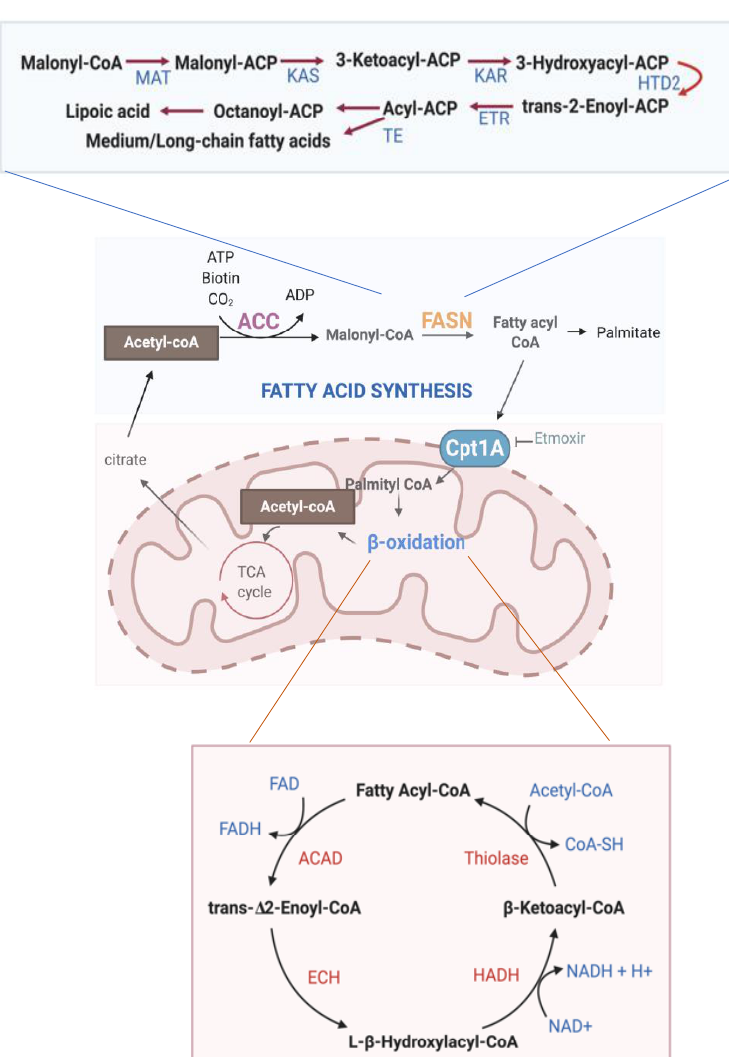
Figure 3. Overview of fatty acid metabolism. ( A ) Fatty acid synthesis pathway. Upper panel: the processing of malonyl-CoA by multifunctional domains of FASN. Sequential molecules and key enzymes are described in a schematic diagram. ACC, acetyl-CoA carboxylase; FASN, fatty acid synthase; FASN domains: MAT, malonyl-CoA transferase; KAS, ketoacyl synthase; KAR, ketoacyl reductase; HTD2, hydroxyacyl-thioester reductase type 2; ETR, enoyl-thioester reductase; TE, thioesterase. ( B ) Fatty acid oxidation pathway. Cpt1A (Carnitine Palmitoyl transferase 1A) catalyzes the rate-limiting step in fatty acid oxidation. Sequential molecules and key enzymes are described in the bottom schematic diagram. ACAD, acyl-CoA dehydrogenase; ECH, enoyl-CoA hydratase; HADH, hydroxyacyl-CoA